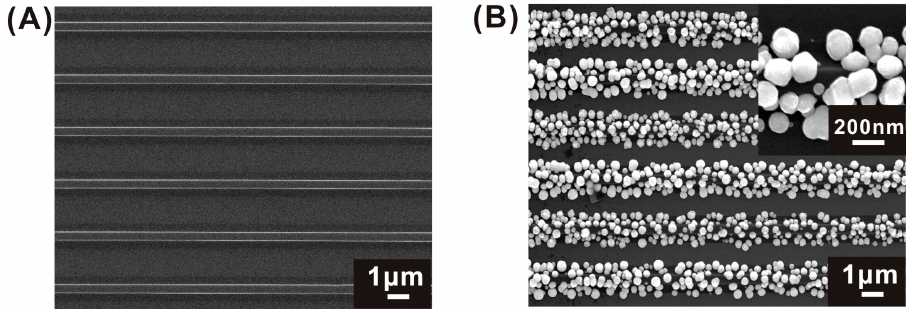
Figure 2. Scanning electron microscope (SEM) images of ( A ) bare carbon IDEs and ( B ) AuNP/carbon IDEs.